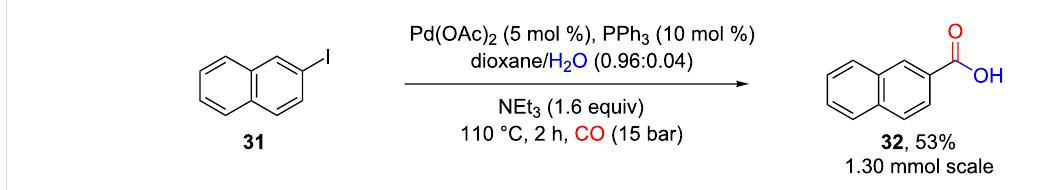
Scheme 5: Flow carbonylation of 2-iodonaphtalene.